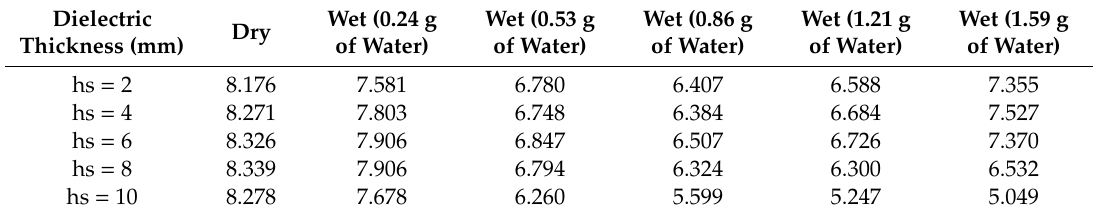
Table 6. Gain (dBi) of the simulated radiation pattern of antenna performance for the dry and wet conditions at 2.45 GHz.